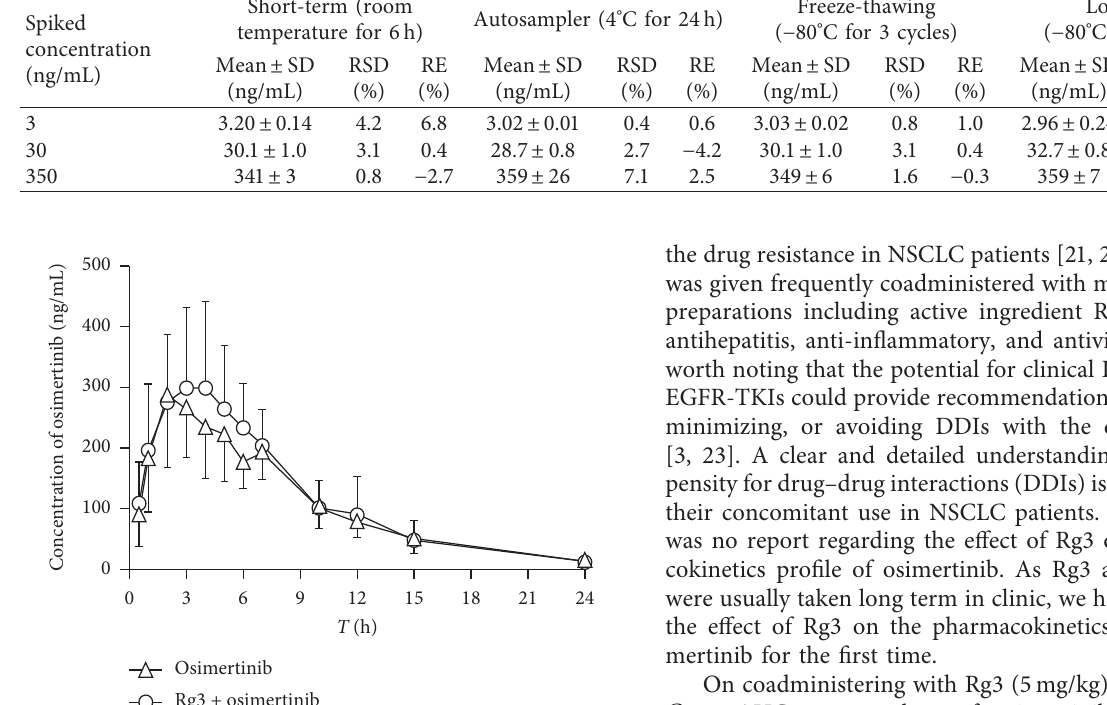
Figure 4: Mean plasma concentration–time profiles of osimertinib in male rats (each point represents mean ± SD). (A) Mean plasma concentration–time profiles of osimertinib after intravenous ad- ministration at a single dose of 10mg/kg in male rats ( n � 10); (B) mean plasma concentration–time profiles of osimertinib after intravenous administration in presence of Rg3 (5mg/kg, 7 days) in male rats ( n � 6). Table 6: Pharmacokinetic parameters of osimertinib following oral administration (10mg/kg) to male rats in the presence or absence of Rg3 (5mg/kg, 7 days, i.g. , n � 6 for each). PK parameter Osimertinib alone Rg3+